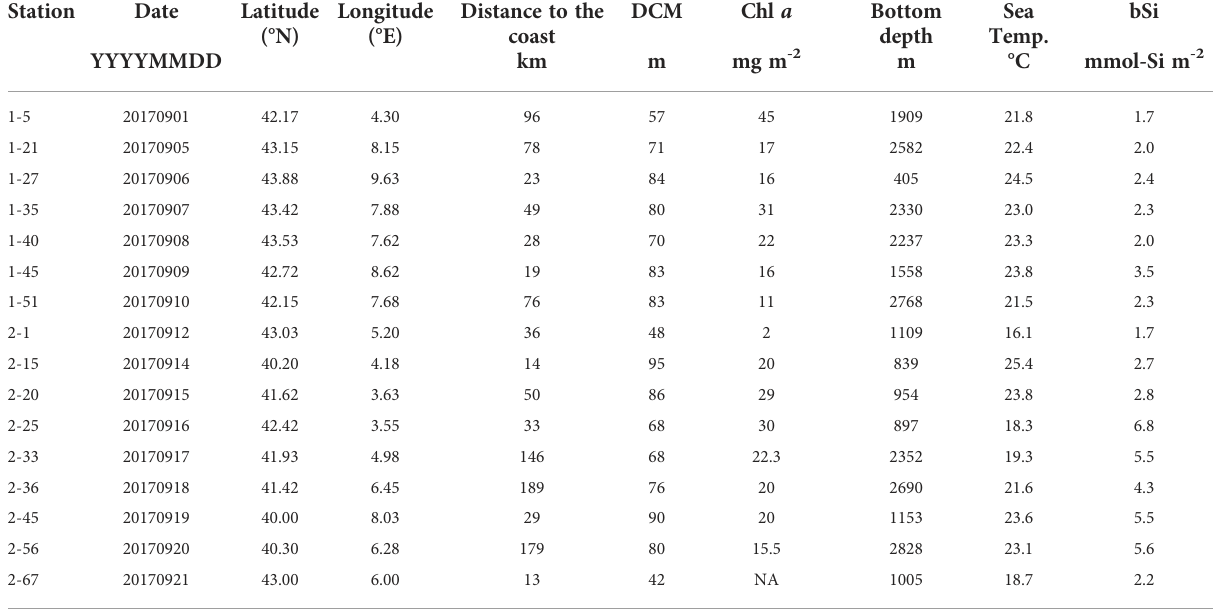
TABLE 1 Study sites location and collection date. Chlorophyll a (Chl a ) and biogenic silica (bSi) values were integrated over the 0-DCM layer.